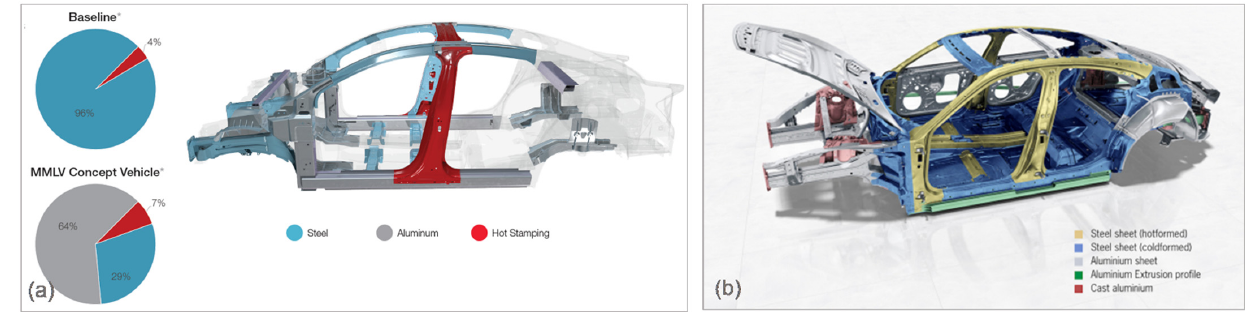
Figure 8. Multi ‐ material designs of ICE and EV (body ‐ in ‐ white): ( a ) ICE, multi ‐ material lightweight vehicle (MMLV), Figure 8. Multi-material designs of ICE and EV (body-in-white): ( a ) ICE, multi-material lightweight vehicle (MMLV), Magna, 2015 [33], and ( b ) EV, Porsche 800 V Taycan electric sports car, 2019 [35]. Magna, 2015 [33], and ( b ) EV, Porsche 800 V Taycan electric sports car, 2019